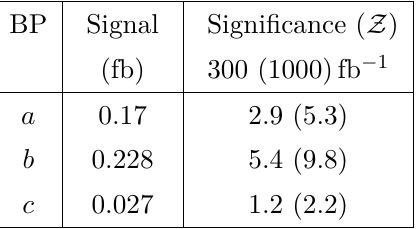
Table 4 . The signal cross sections after selection cuts and the corresponding significances of the bZh process with 300 (1000) fb − 1 integrated